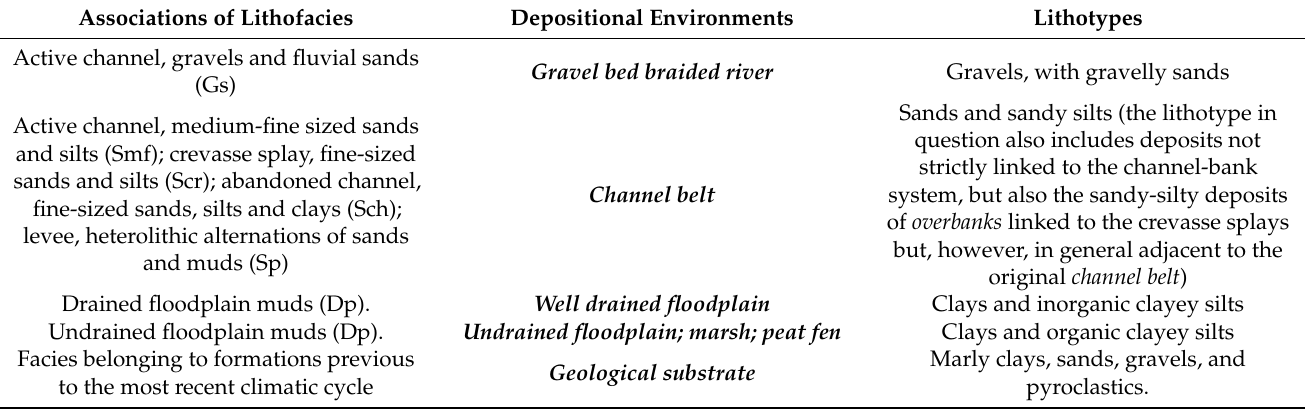
Table 5. Comparison between associations of lithofacies, depositional environments, and reference lithotypes for the integrated